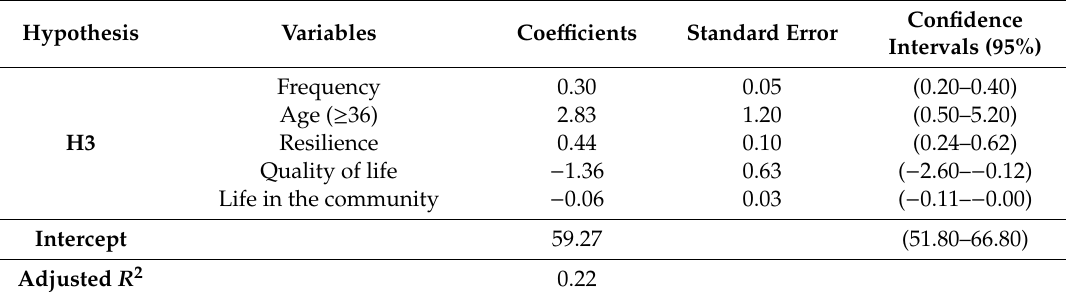
Table 6. Specifications for the regression of felt impacts as a function of frequency of environmental changes, age, resilience, and quality of life (H3, Model